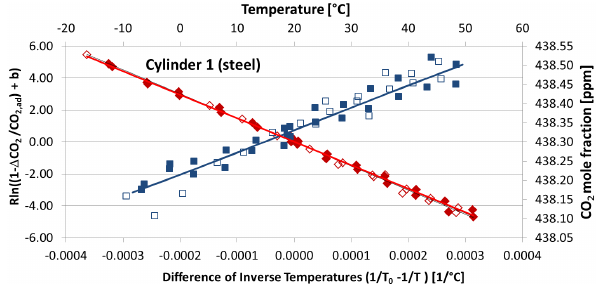
Figure 7. Dependence of scaled CO 2 mole fraction difference plus offset b on the difference of inverse temperature for the steel cylin- der 1 according to Eq. (6). Open red symbols correspond to decreas- ing temperature; and filled red symbols correspond to increasing temperature shown in Fig. 1. The correlation is excellent ( r 2 = 1), therefore the slopes correspond to the negative desorption energy (Eq. 6) as we have changed the x axis with a minus sign due to visibility reasons. The desorption energies do slightly differ from 14.74 to 15.10kJmol − 1 for increasing and decreasing temperature, respectively, with a mean of 14.88kJmol − 1 for the overall corre- lation using a CO 2 , ad value of 1.2ppm and 0.0168bar − 1 for K 0 . Open and filled blue symbols correspond to the CO 2 mole fractions vs. temperature, whereas the blue line corresponds to the estimated CO 2 mole fractions according to Eq.